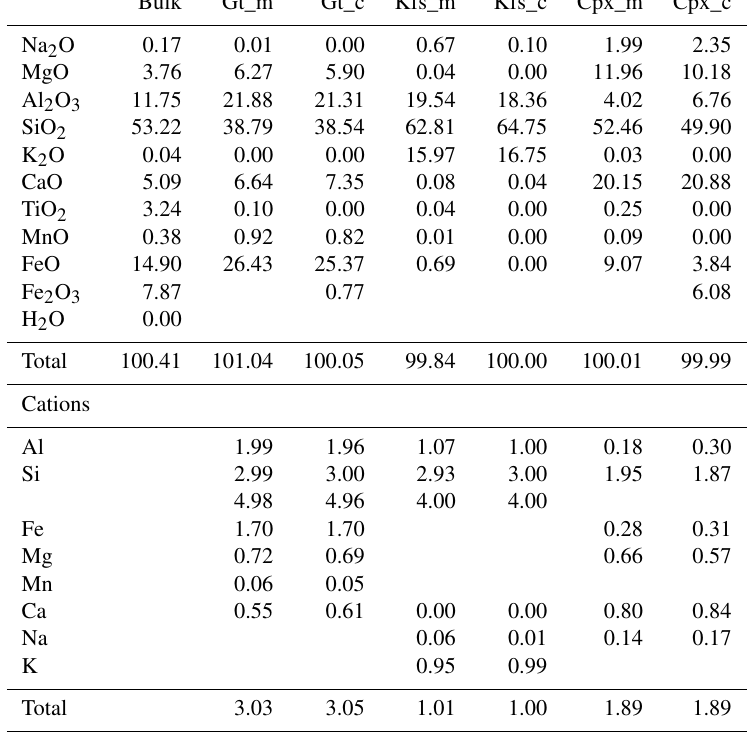
Table B3. Representative analysis for sample F6; m: measured; c: calculated from Perple_X at 1.17GPa and 590 ◦ C; Fe 2 O 3 calculated on the basis of volume per cent of phases. Solution models Gt(WPH), IlHm(A), MtUl(A), Omph(HP), GlTrTsPg, melt(HP), Chl(HP), Sp(HP),